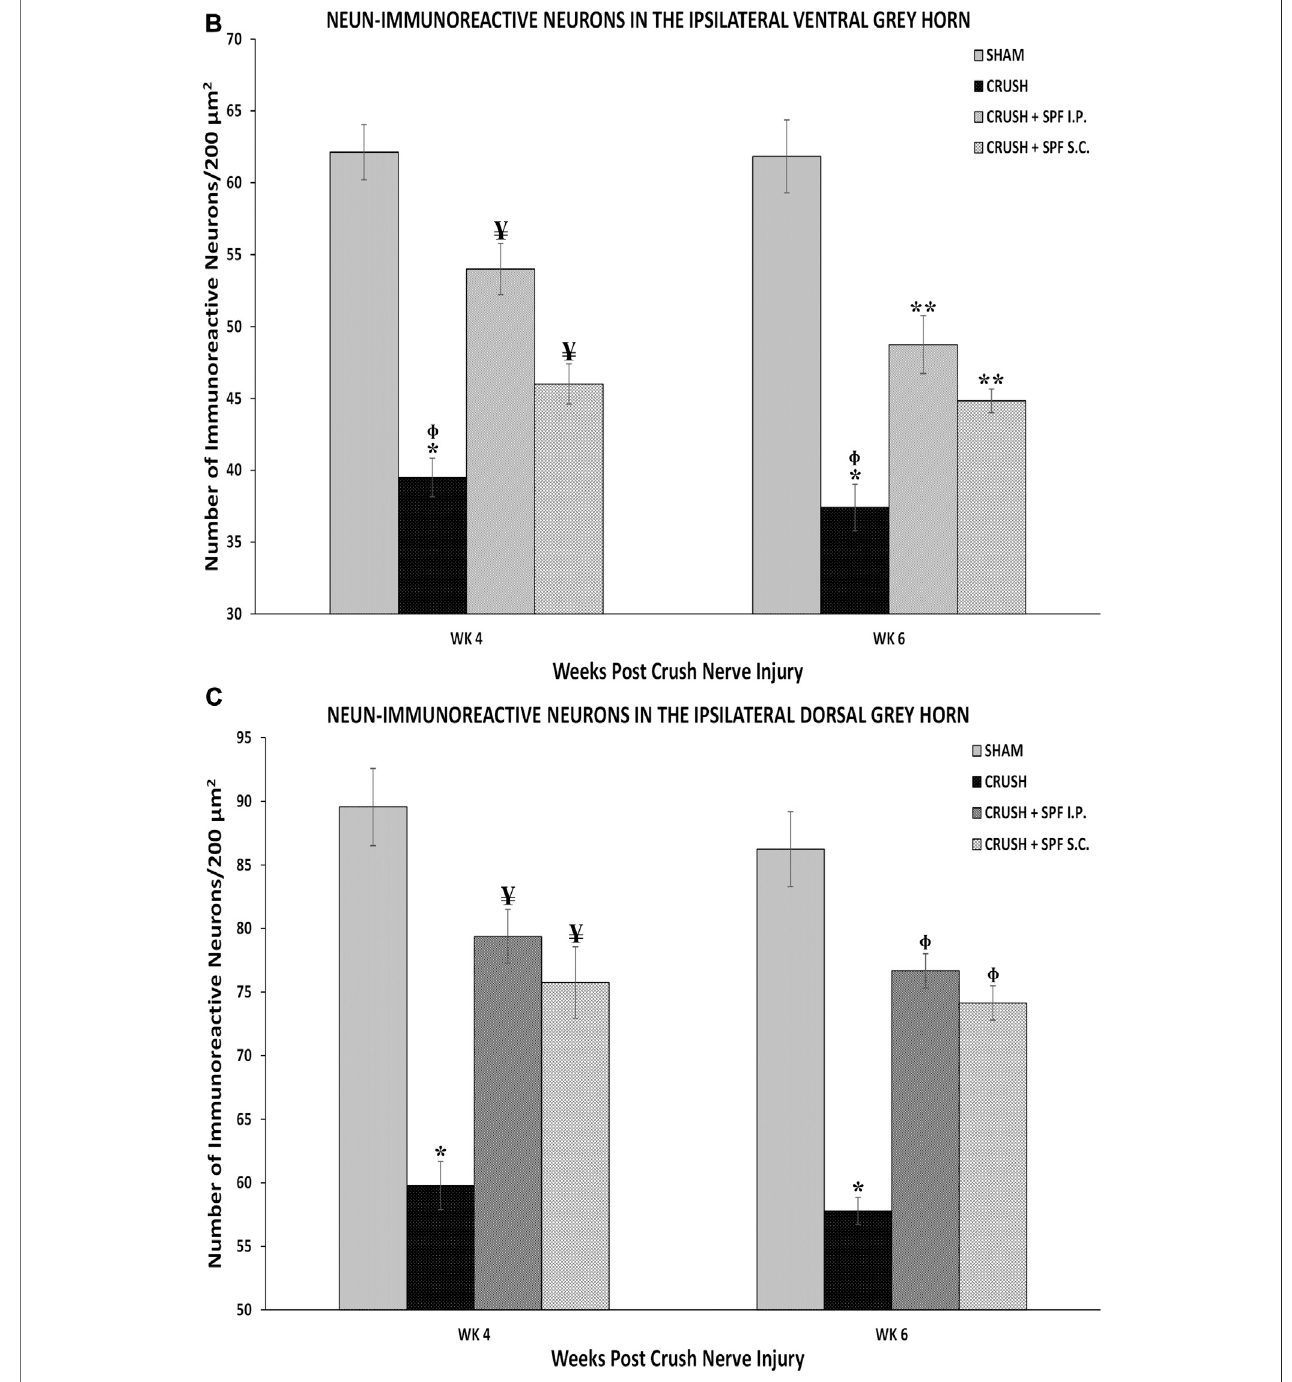
FIGURE8|(A) :Representative40 × and100 × photomicrographsoflumbarspinalcordventralgreyhornimmunostainedforNeuNatWeek4andWeek6post-injury.Noteless numberofNeuN-immunostainedneuronsinthesciaticnerve-injuredgroup(CRUSH)comparedtotheSHAMgroup.ThenumberoftheNeuN-immunoreactiveneuronsareremarkably moreintheCRUSH+SPF-FB(IP)andCRUSH+SPF-FB(S.C.)-treatedgroupscomparedtotheCRUSHgroup. (B): BargraphshowsthenumberofNeuN-immunoreactiveneuronsin theipsilateralventralgreyhornatWeek4andWeek6post-injury.Notethesigni fi cantdecreaseinthenumberofNeuN-immunostainedneuronsintheCRUSHgroup.Further,the numberofneuronssigni fi cantlyincreasedintheCRUSH+SPF-FB(IP)andCRUSH+SPF-FB(S.C.)-treatedgroupsatWeek4andWeek6post-injury.*indicates p < 0.0001CRUSH vs.allgroups;¥indicates p < 0.003CRUSH+SPF-FB(IP)andCRUSH+SPF-FB(S.C.)vs.SHAM; Φ indicates p < 0.008CRUSHvs.CRUSH+SPF-FB(S.C.);**indicates p < 0.0001 CRUSH+ SPF-FB(IP) and CRUSH+SPF-FB(S.C.) vs. SHAM. (C) : Bar graph showsthe number ofNeuN-immunoreactiveneurons in theipsilateral dorsalgrey horn at week 4and week6post-injury.Similarly,notethesigni fi cantdecreaseinthenumberofneuronsintheCRUSHgroup.Incontrast,IPandS.C.SPF-FBtreatmentssigni fi cantlyincreasedthenumber ofNeuN-immunoreactiveneuronscomparedtoCRUSHanimals.*indicates p < 0.0001CRUSHvs.Allgroups;¥indicates p < 0.02CRUSH+SPF-FB(IP)andCRUSH+SPF-FB(S.C.) vs. SHAM; Φ indicates p < 0.004 CRUSH + 0.5X SPF-FB(IP) and CRUSH + 1X SPF-FB(S.C.) vs. SHAM.